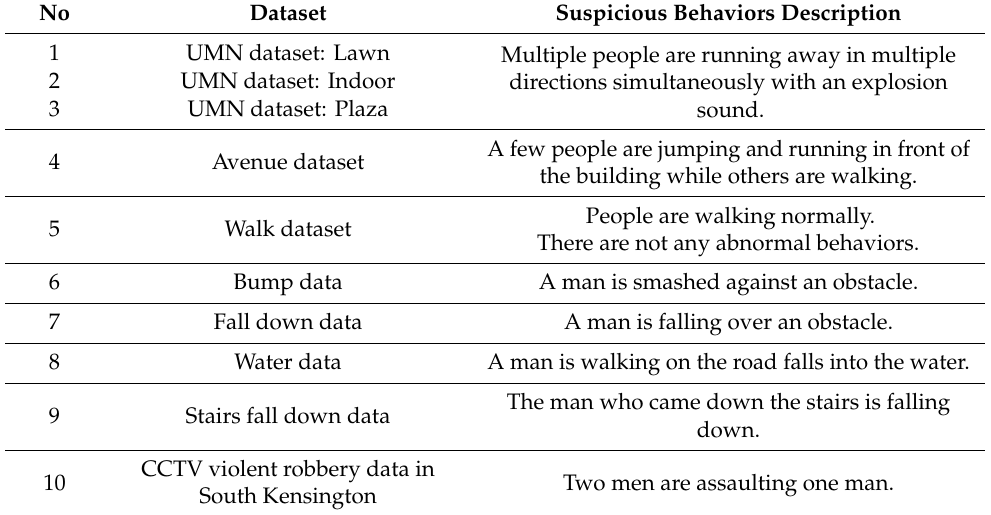
Table 1. Dataset and types of suspicious behaviors used in the proposed